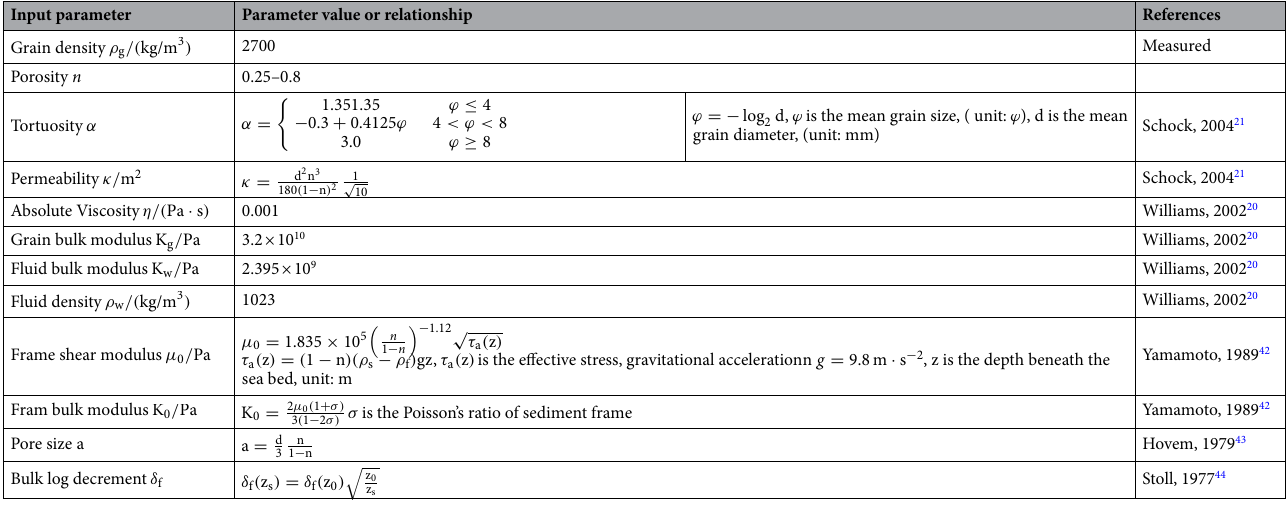
Table 1. Parameters and property interrelationships used to generate inputs for the